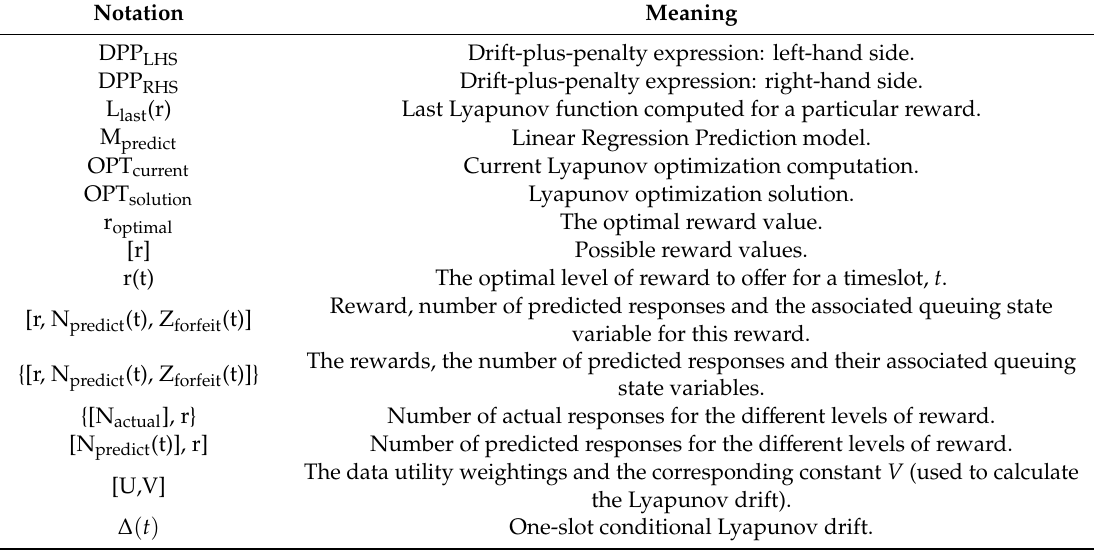
Table 1. Additional notations for Algorithm